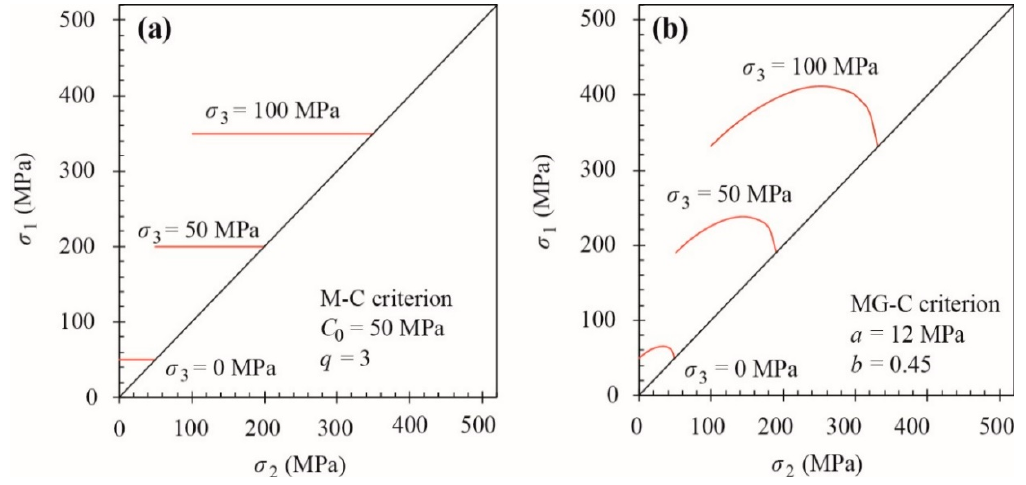
Figure 8. Plot of strength criteria in { σ 1 - σ 2 } space (Modified from [40]). ( a ) M-C criterion; ( b ) MG-C criterion.